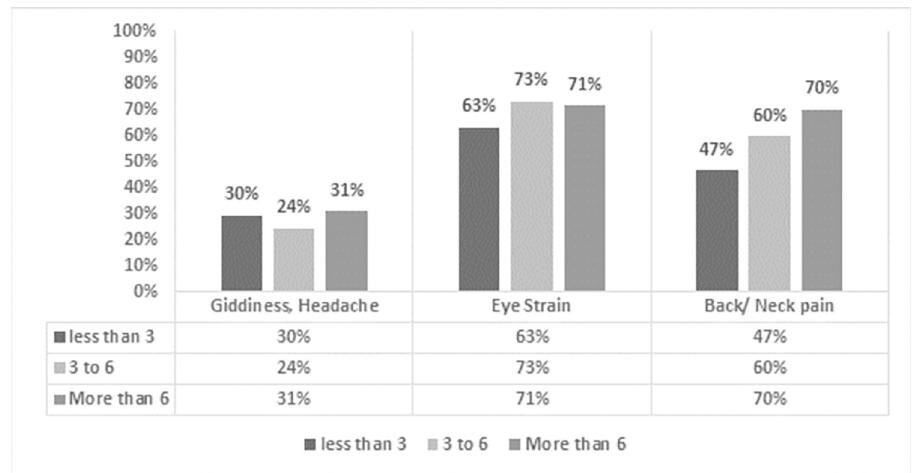
Fig 2. Number of working hours and types of physical health